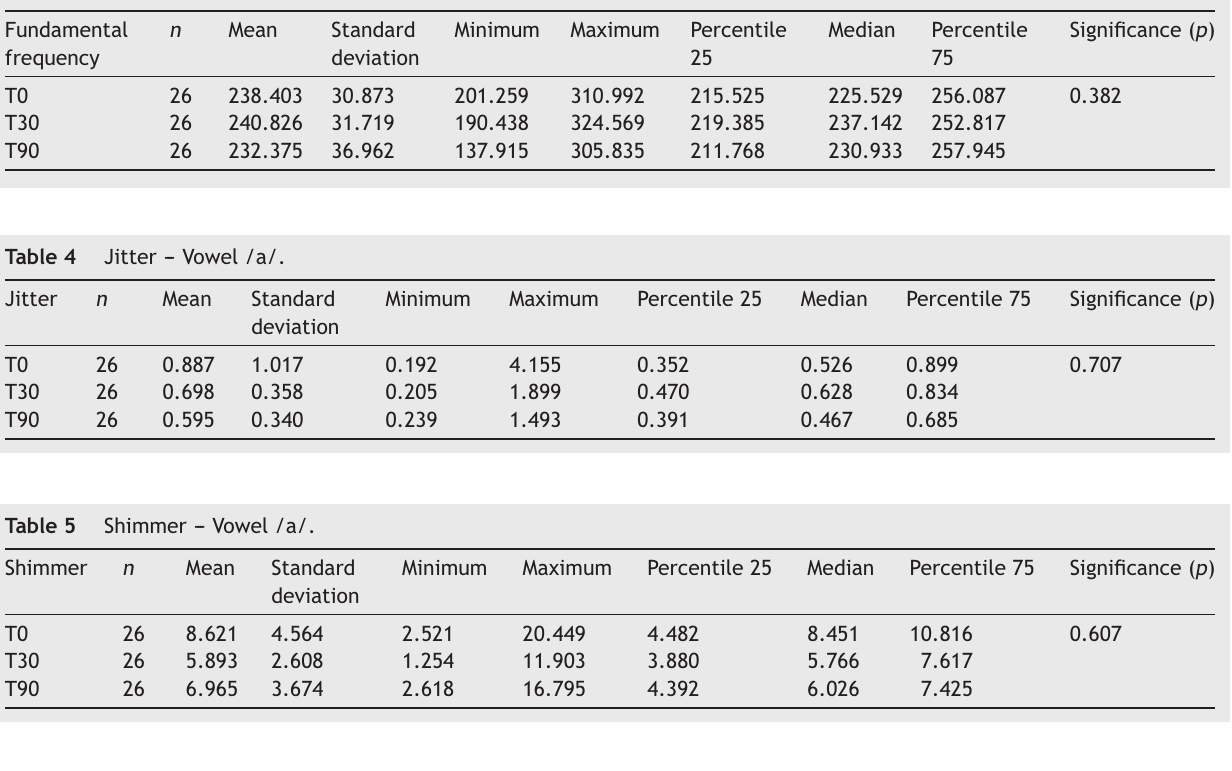
Harmonic---noise ratio --- Vowel /a/. Harmonic---